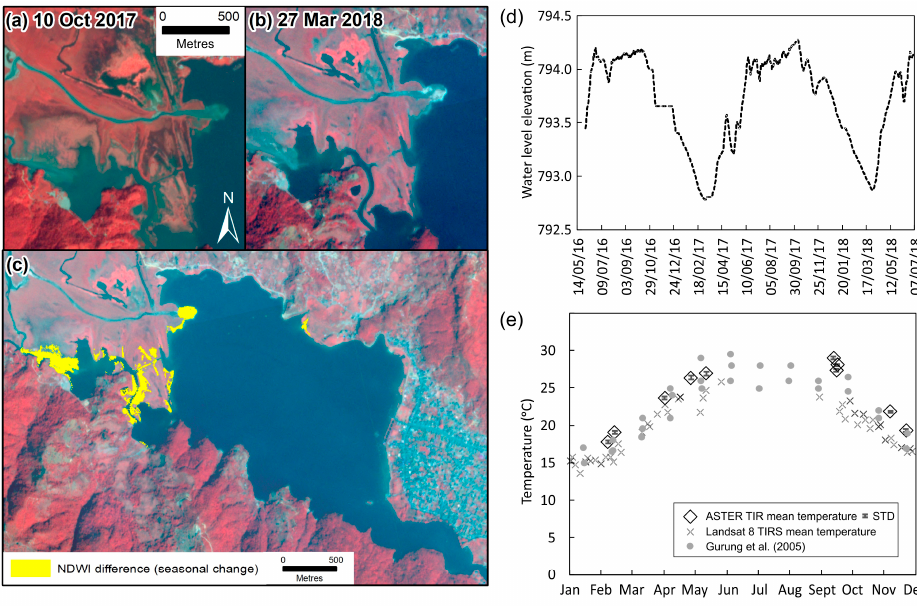
Figure 3. Seasonal changes at Phewa Lake. ( a–c ) Shoreline change between high (10 October 2017) and low (27 March 2018) water levels. Backgrounds are RapidEye false colour composites (bands: near-infrared, red, and blue). ( d ) Water level elevation recorded at Phewa Dam with a seven-day moving average. ( e ) Mean lake temperature derived from ASTER Thermal Infrared (n = 10, 2000–2018), Landsat 8 Thermal Infrared Sensor (n = 48, 2013–2018), and Gurung et al. (2005) (n = 30, 2000–2002).